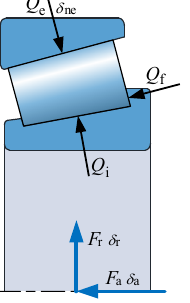
Figure 10. Tapered roller forces and bearing forces.